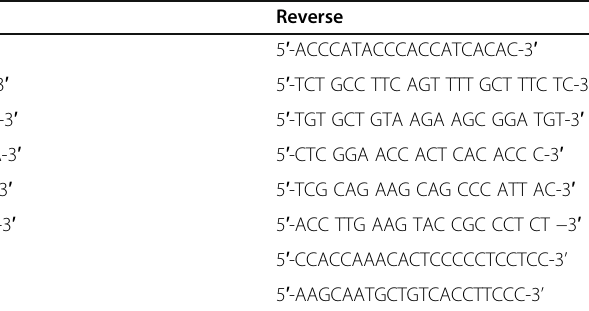
Table 1 Primer sequences Gene